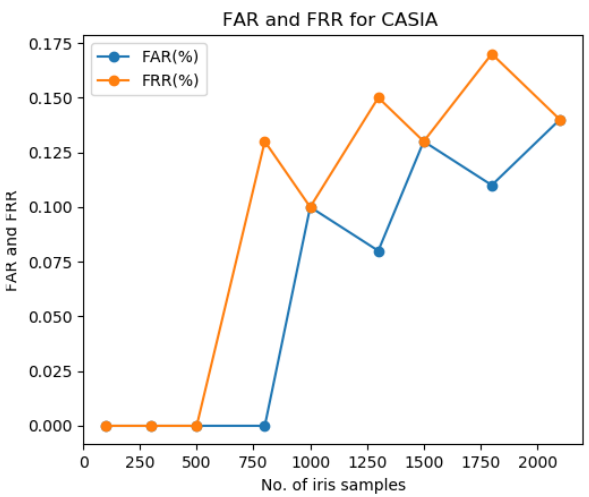
Figure 4. Plot of FAR, FRR in CASIA iris dataset.